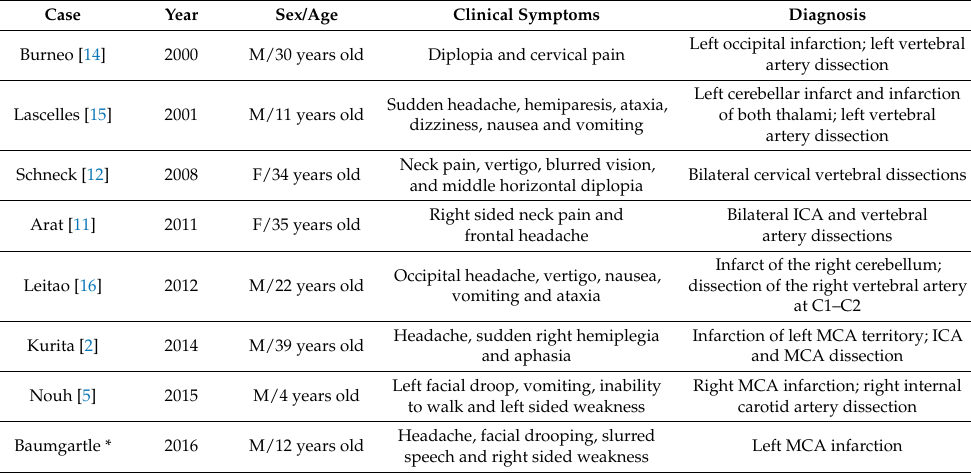
Table 1. Cases of infarctions and dissections in adults and children after amusement park